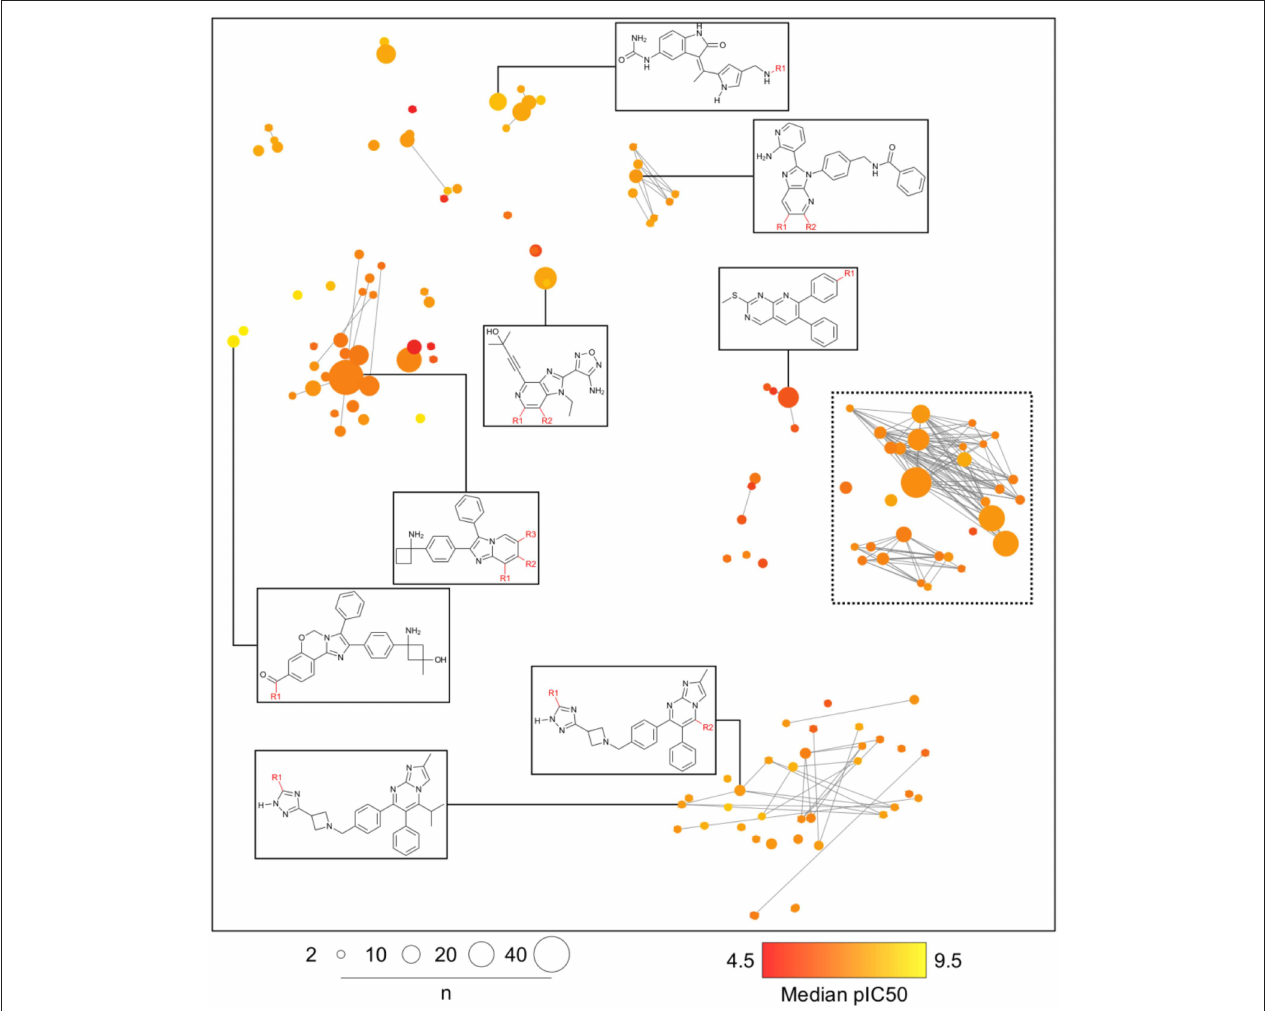
FIGURE 5 | General constellation plot for a dataset of AKT1 inhibitors. It is possible to navigate this map, as observed in Figure 6 , where the constellation framed within dashed lines is further explored.